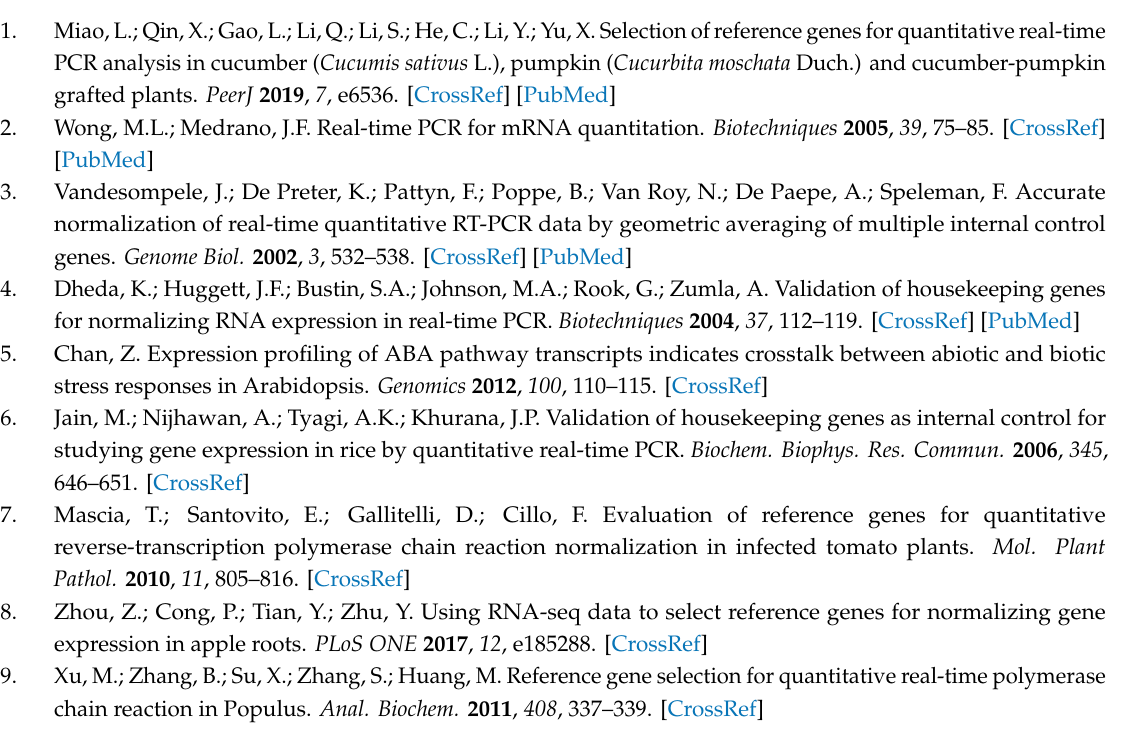
Figure S1: Agarose gel electrophoresis of PCR products for each of the 16 RGs and the one target genes in Larix olgensis. , Figure S2: Melting curve for 16 RGs and one target gene CAT in L. olgensis , Figure S3: Average expression stability values ( M -values) of the 16 RGs in L. olgensis calculated by geNorm. Table S1: Expression stability ranking of the 16 candidate reference genes under di ff erent abiotic stresses in L . olgensis